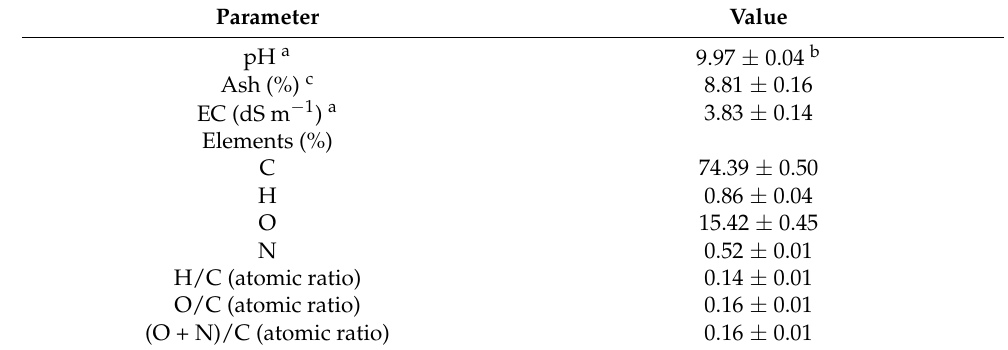
Table 1. Some properties of